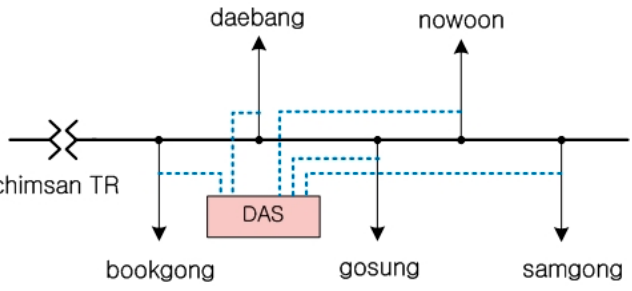
Figure 3. Configuration of the Chimsan substation. Table 1. Data acquisition line and date of the Chimsan substation.